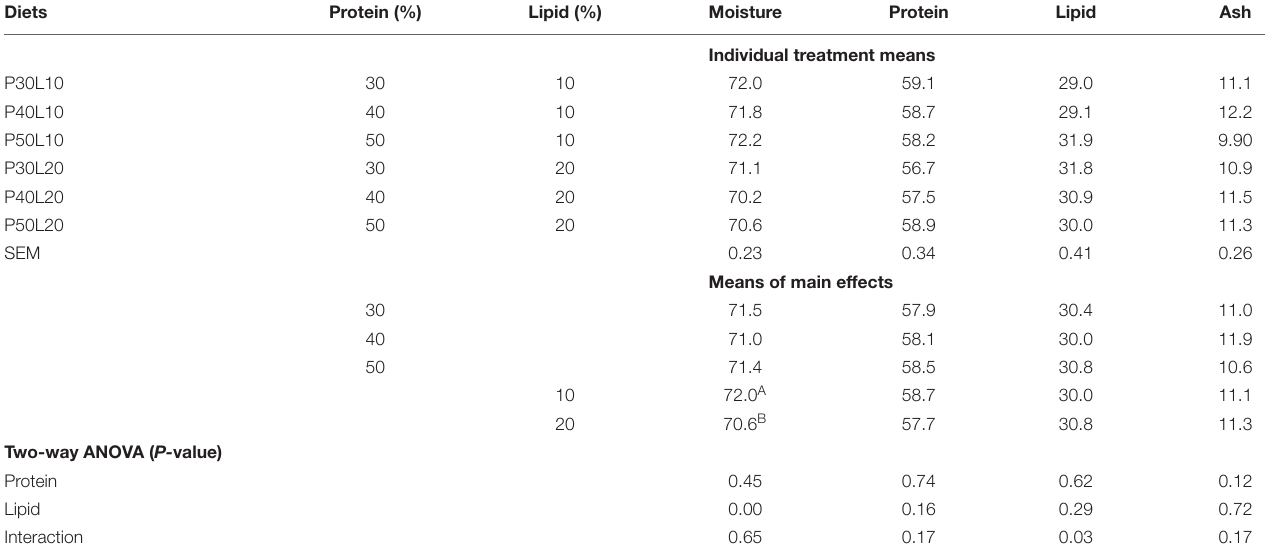
TABLE 4 | Whole-body proximate composition (% dry weight) of European grayling ( Thymallus thymallus ) fed the experimental diets for 12 weeks. Diets Protein (%) Lipid (%) Moisture Protein Lipid Ash Individual treatment means 30